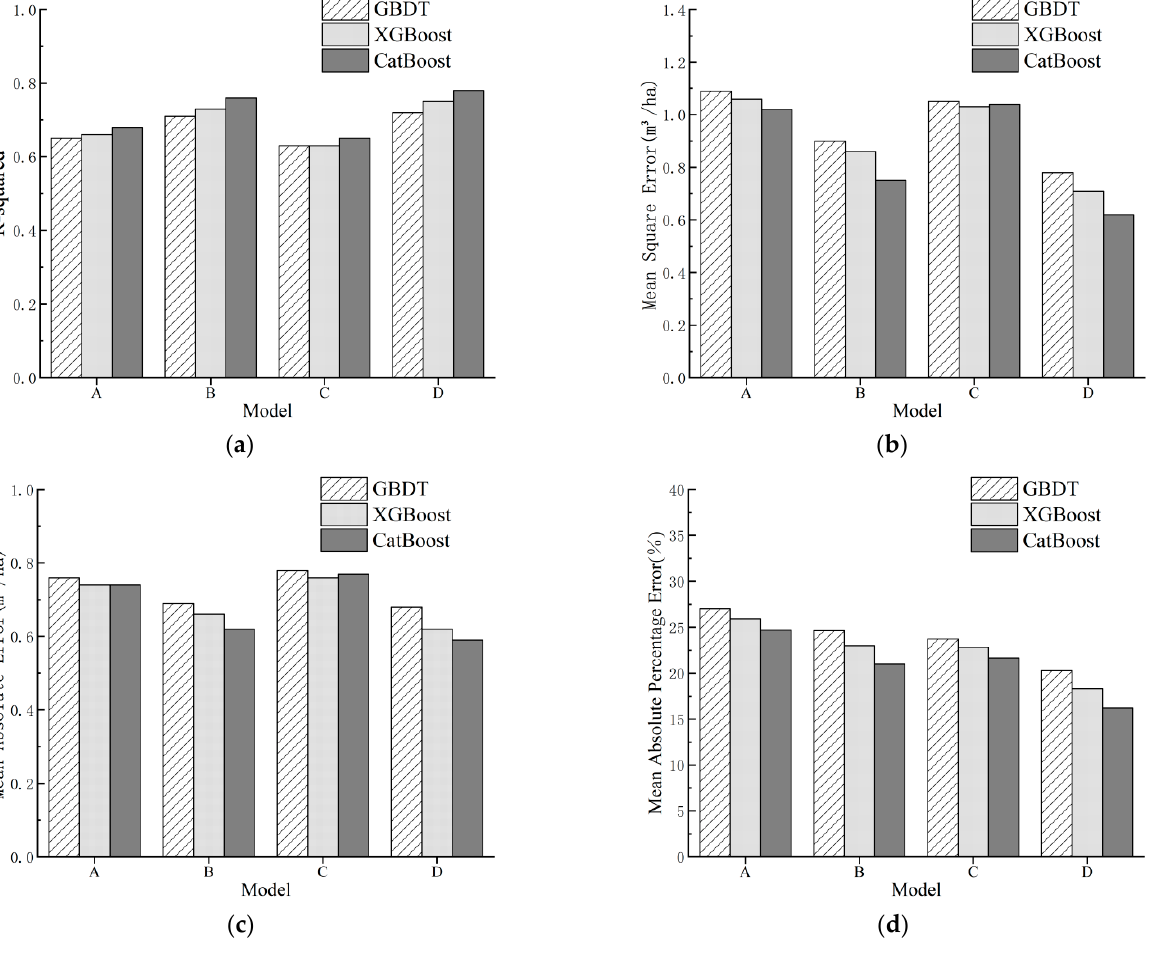
Figure 5. Comparison of performance indicators generated by the models GBDT, XGBoost, and CatBoost based on data schemes A, B, C, and D. ( a ) R-squared; ( b ) mean square error; ( c ) mean absolute error; ( d ) mean absolute percentage error. A—Without category features, with single remote sensing data. B—With category features, with single remote sensing data. C—Without category features, with multi-source remote sensing data. D—With category features, with multi-source remote sensing data.